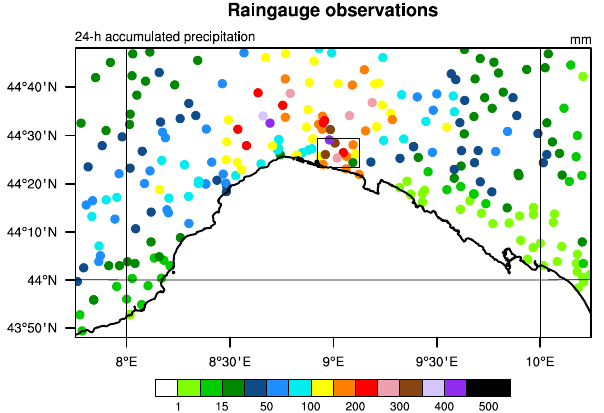
Figure 1. 24h observed rainfall amounts for the Liguria region be- tween 00:00UTC on 4 November and 00:00UTC on 5 Novem- ber 2011. The Bisagno region is highlighted by the black rectangle.